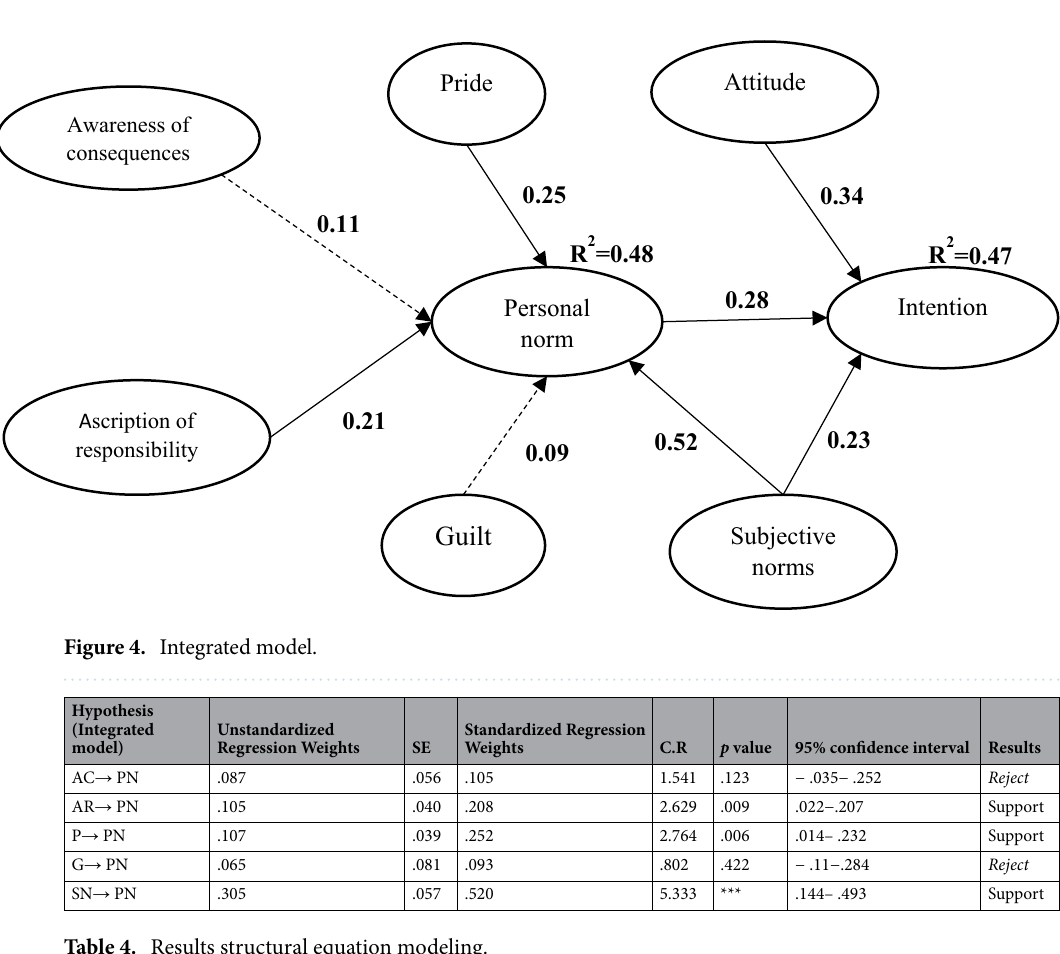
Table 4. Results structural equation